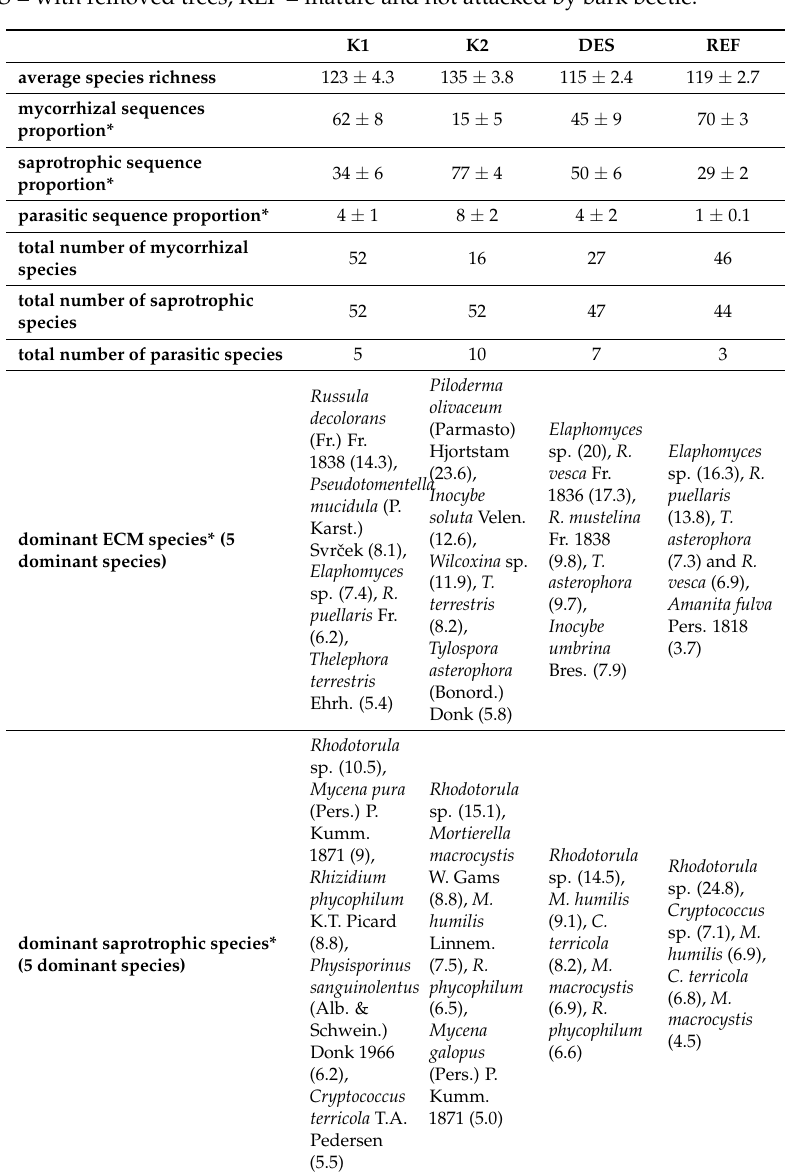
Table 1. Species richness, the relative sequence proportion, the number of species and dominating ECM, and saprotrophic species in the forest. K1 = attacked by bark beetle; K2 = destroyed by bark beetle; DES = with removed trees; REF = mature and not attacked by bark